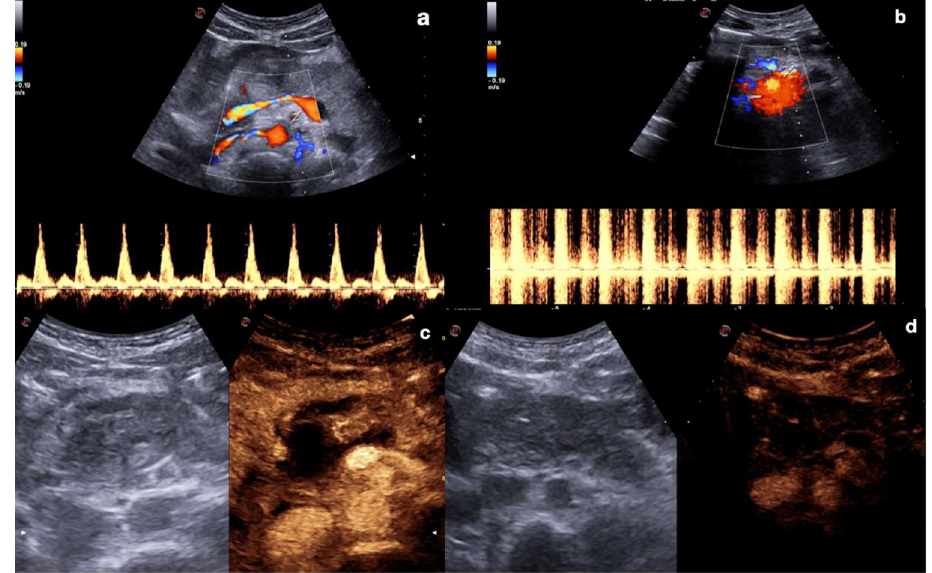
Figure 3. Artifacts in color and spectral Doppler after CEUS ( a , b ), and in repeated CEUS after Doppler ( c , d ). Mesenteric artery color and spectral Doppler before ( a ) and after ( b ) UCA administration showed alteration in the color map (upper row) as well as in the waveform (bottom row) evaluation due to the relative turbulence generated by the micro-bubbles within the vessel. Upper abdomen CEUS in pancreatic trauma before ( c ) and after ( d ) Doppler study shows relative destruction of the micro-bubbles due to high MI during the Doppler study, making the post-Doppler contrast study unable to visualize organs and tissues properly.